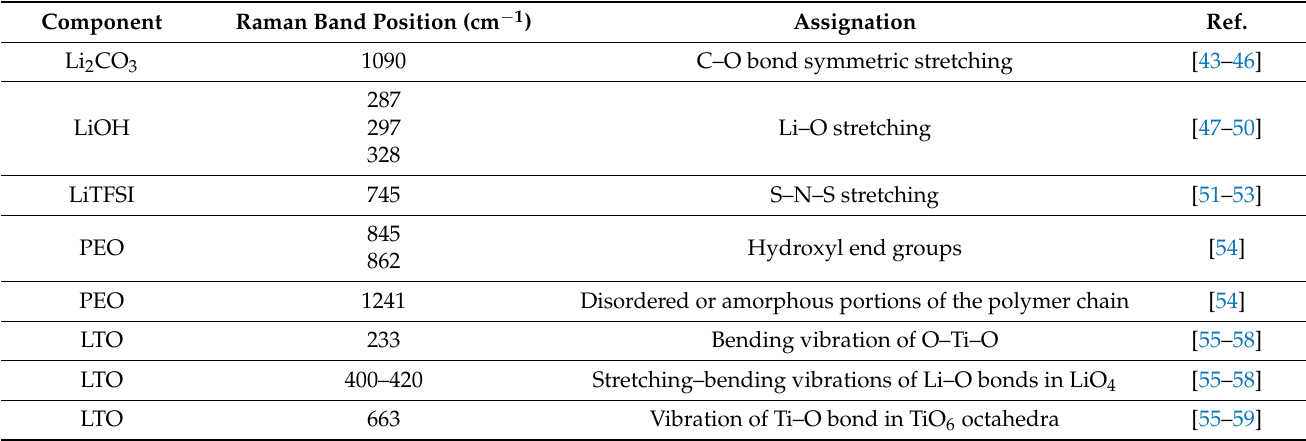
Table 1. Assignations for most significant observed